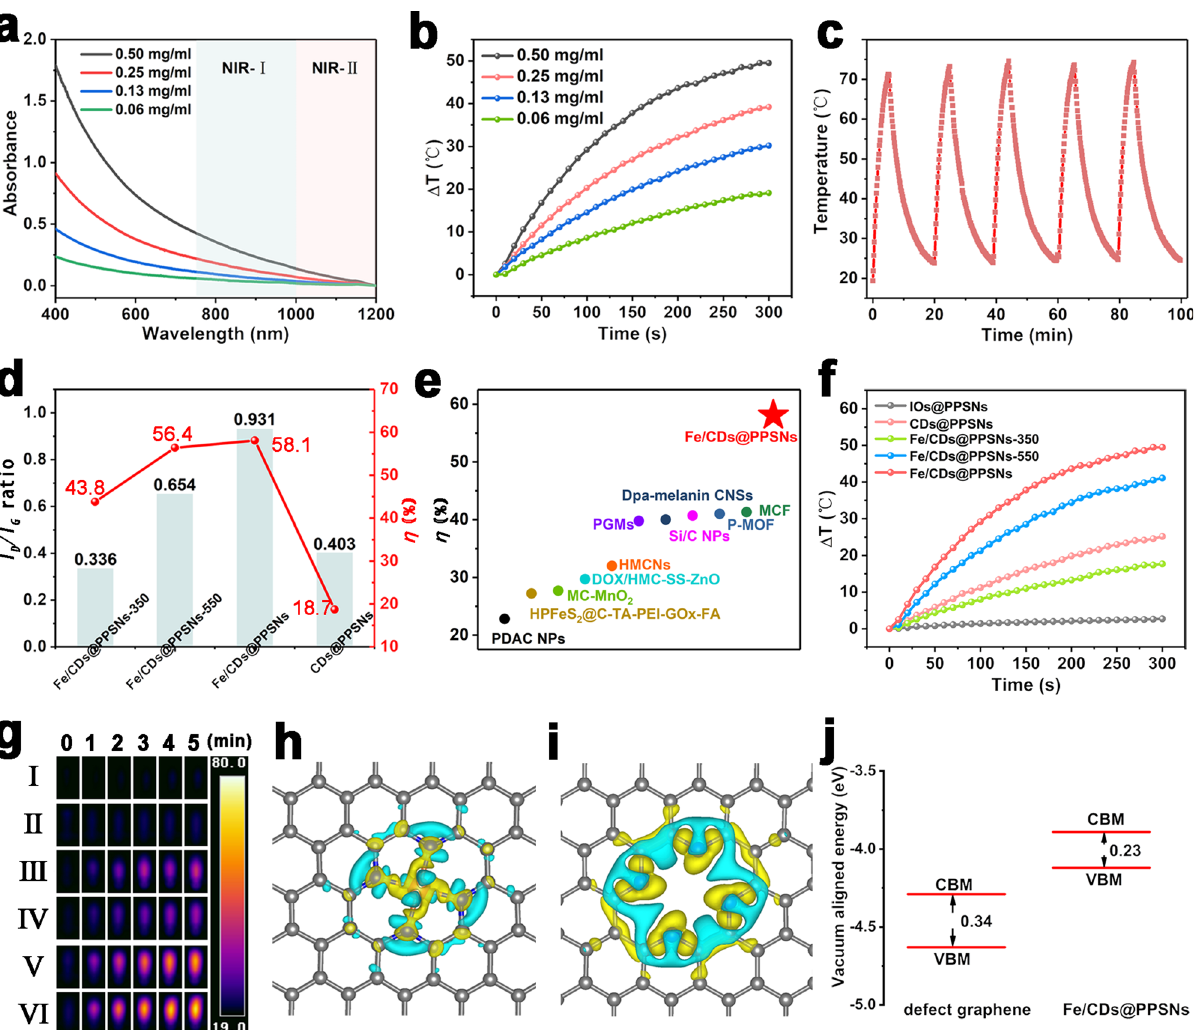
Fig. 4 Photothermal performance and DFT calculations. a UV-vis-NIR spectra of Fe/CDs@PPSNs at different concentrations. b Photothermal heating curves for Fe/CDs@PPSNs dispersions at different dispersion concentrations (808 nm, 2 W/cm 2 ). c Heating curves of Fe/CDs@PPSNs dispersion (0.5 mg/ml) in water for fi ve laser on/off cycles under a NIR laser (808 nm, 2 W/cm 2 ). d I D / I G ratios (derived from the Raman spectra) and